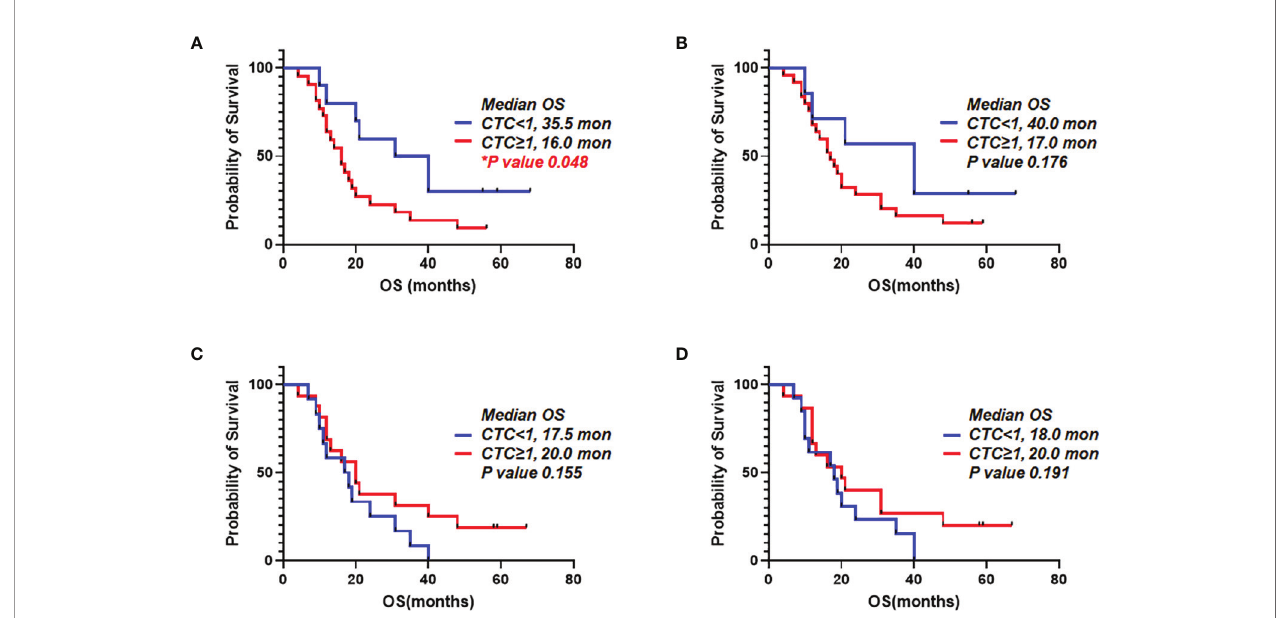
FIGURE 7 | Overall survival correlated to number of circulating tumor cells (CTCs) detected using epithelial cell adhesion molecule (EpCAM) and Plectin-1 in peripheral blood and portal blood. CTC counts based on EpCAM and Plectin-1 expression were evaluated with Overall survival (OS) of 32 PDAC patients. Patients were divided into two groups depending on detectable EpCAM + CTCs in (A) Peripheral vein and (B) Portal vein. Patients were divided into two groups depending on detectable Plectin-1 + CTCs in (C) Peripheral vein and (D) Portal vein. OS was analyzed with the number of CTCs using Kaplan-Meier